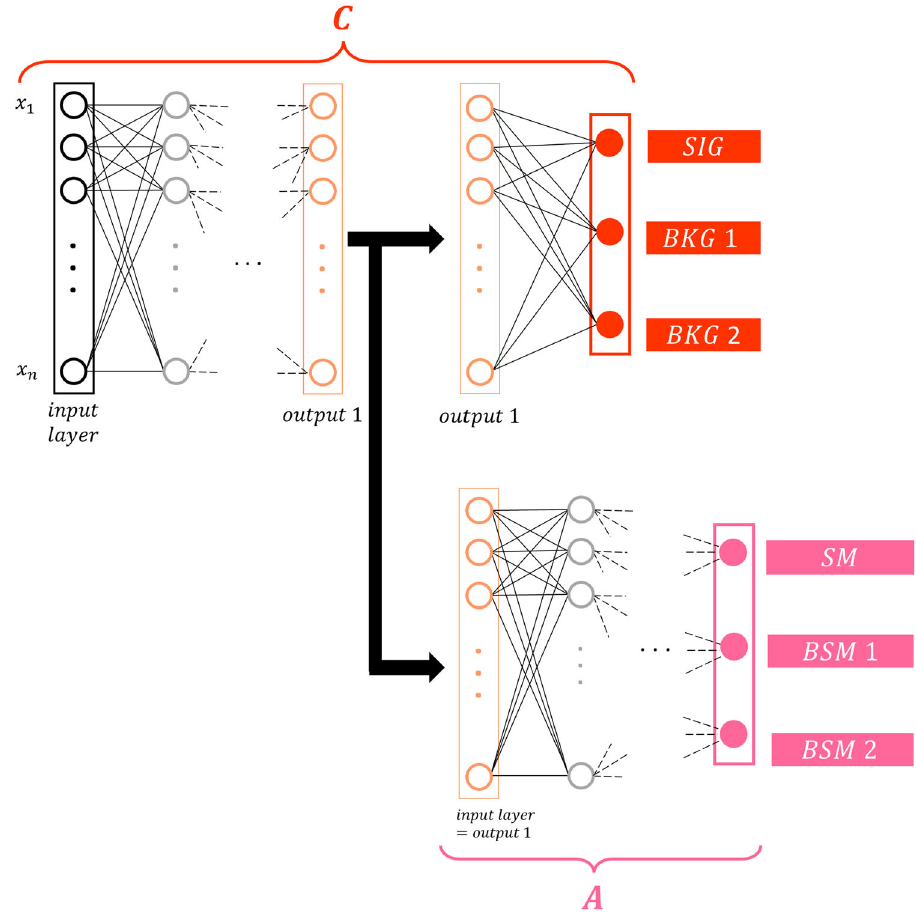
Fig. 1 Schematic view of the adversarial deep neural network